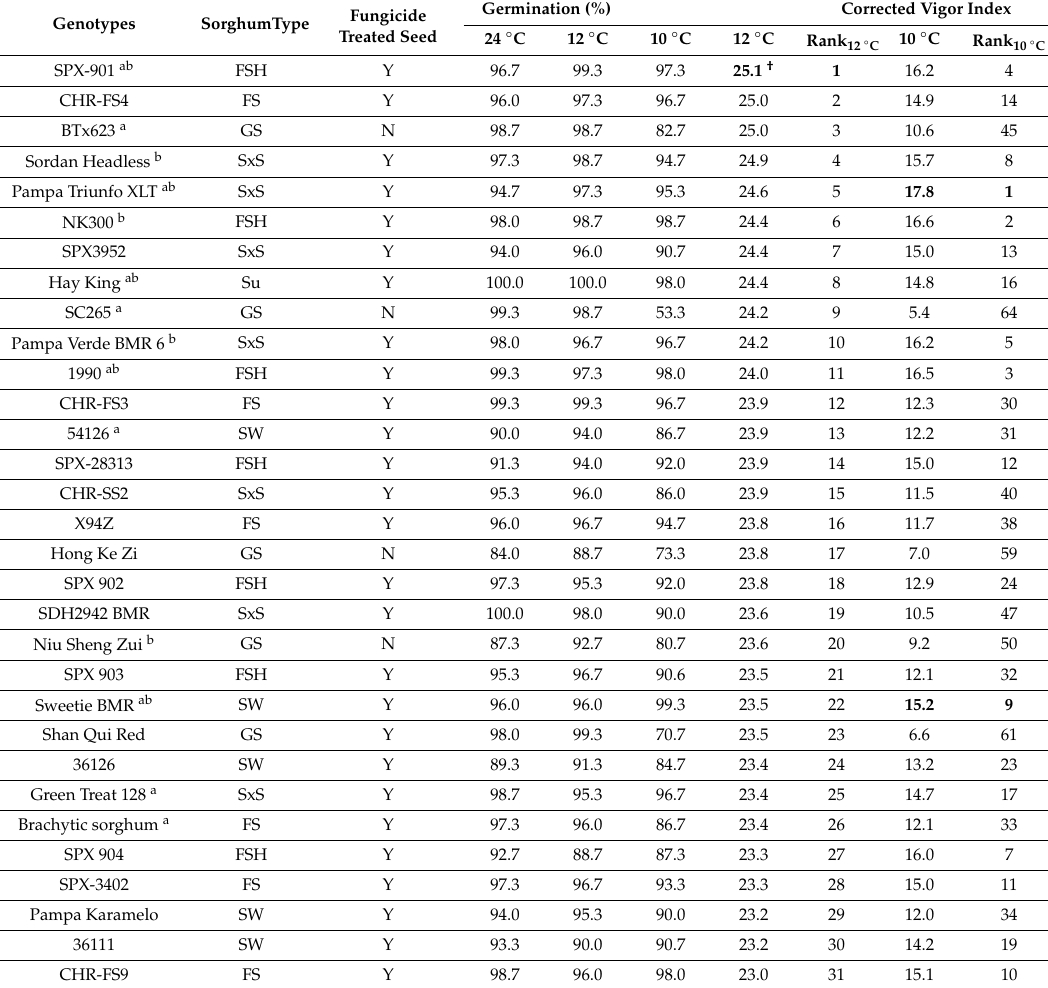
Table 2. Mean seed germination and corrected vigor index of forage sorghum genotypes evaluated at di ff erent temperatures in controlled environment growth chambers in 2017 and 2018.